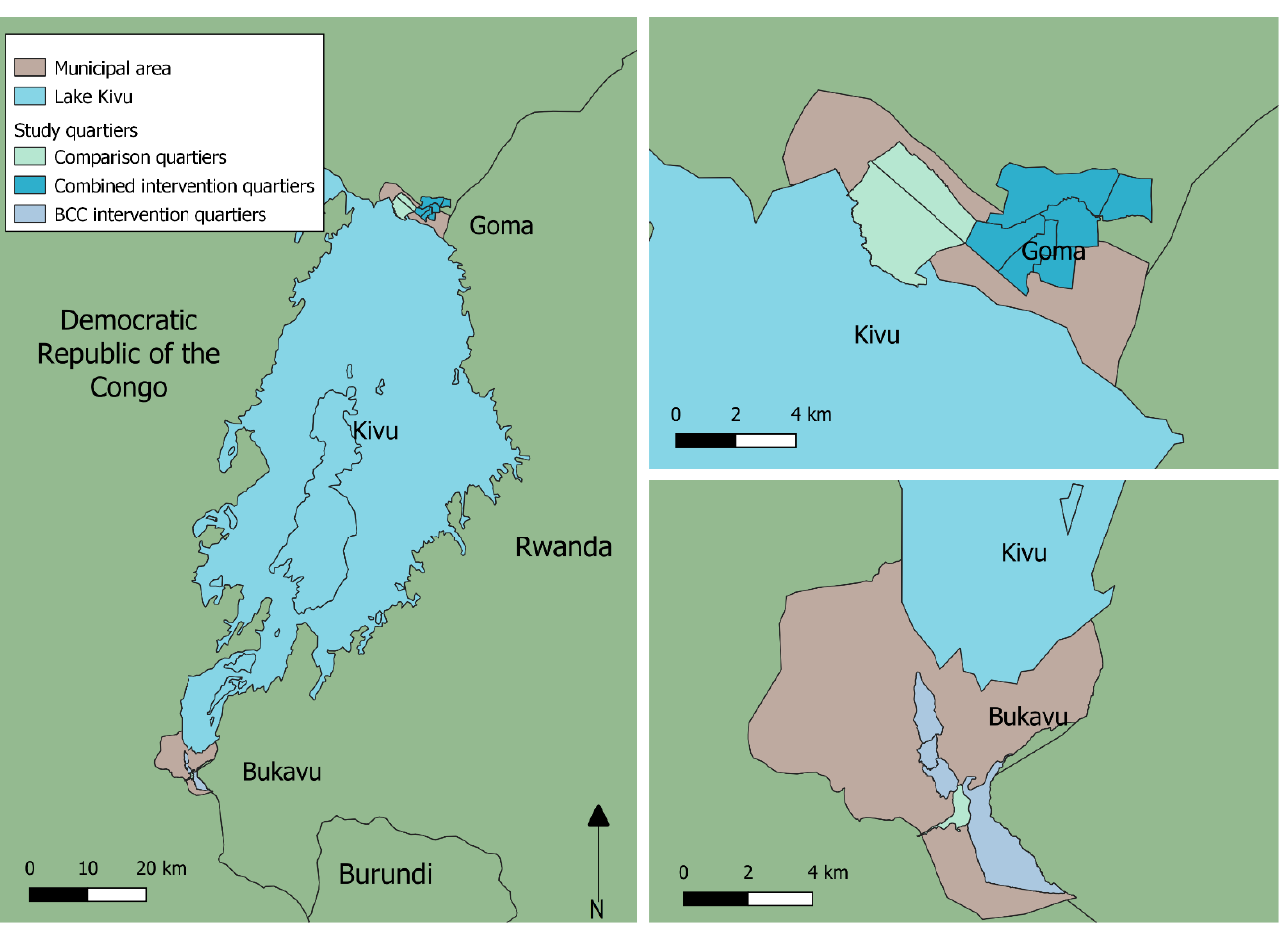
Figure 1. The study sites and surrounding area.